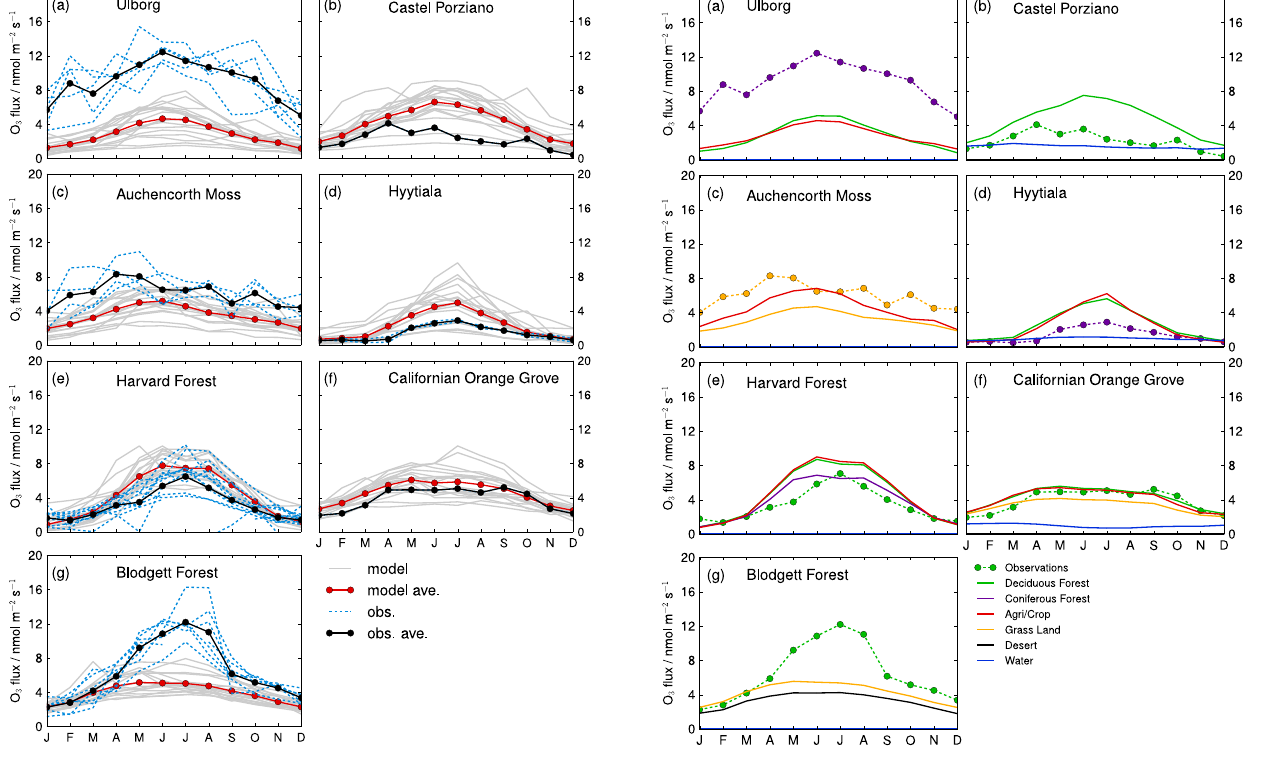
Figure 9. Observed monthly average O 3 dry deposition fluxes at measurement sites (dashed lines) and repartitioned model fluxes for each land cover class (solid lines). Colours indicate the LCC at the site and in the model grid cell containing the